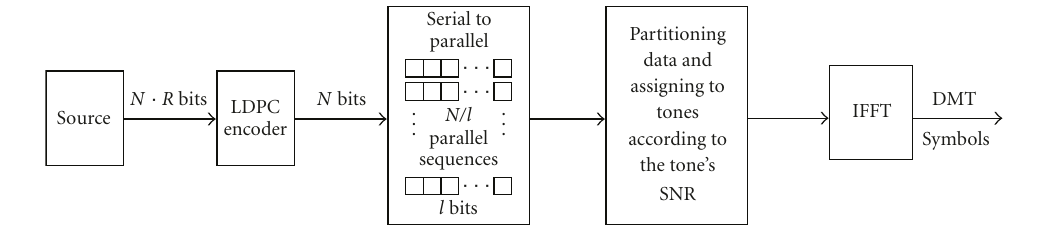
Figure 1: Block diagram of the transmitter. The partitioning is done based on the existing knowledge about the DMT channel.